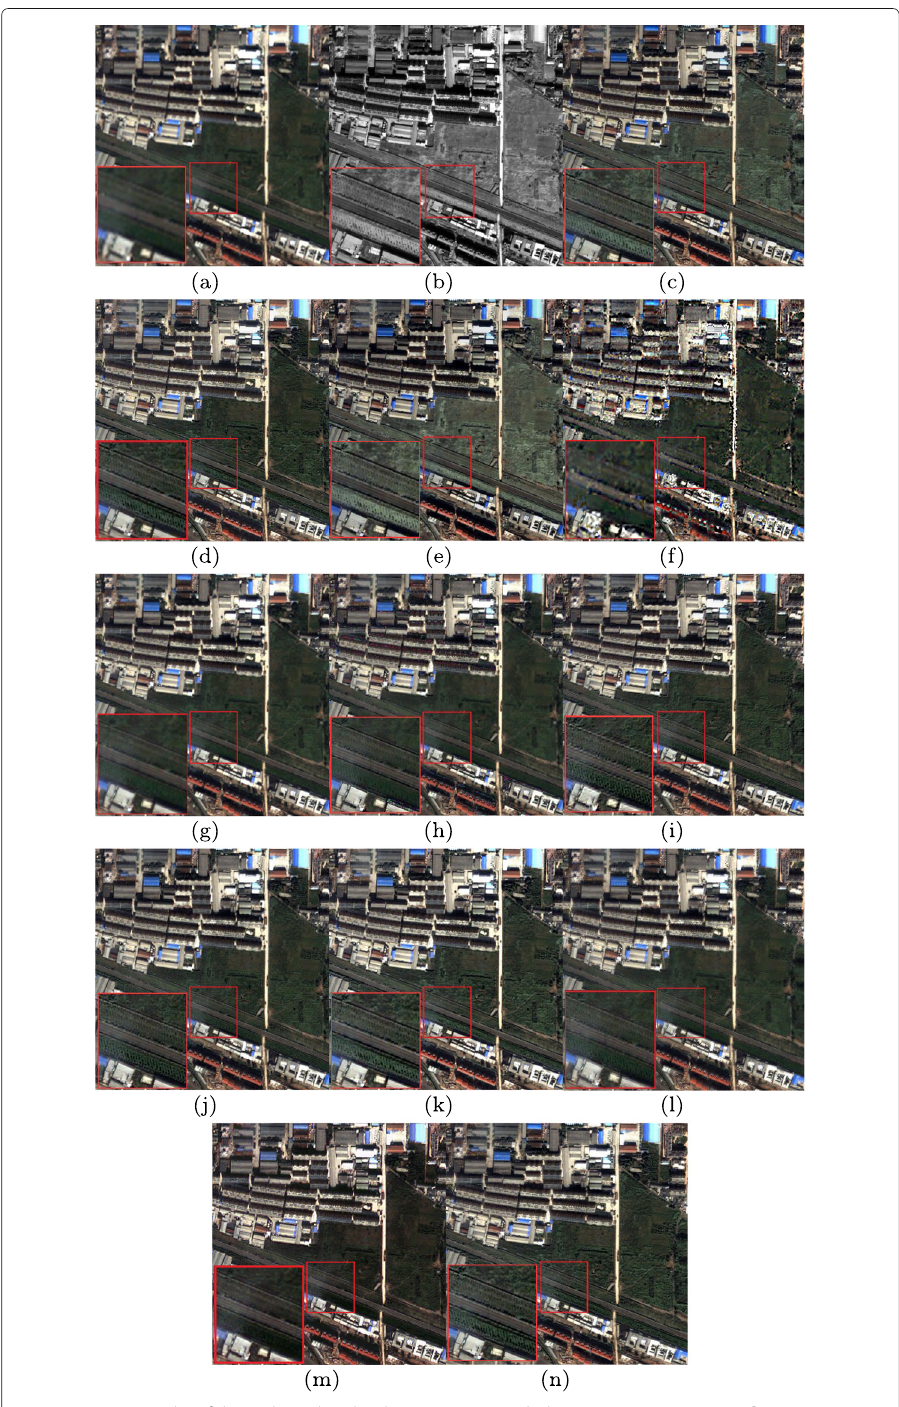
Fig. 10 Fusion results of the real QuickBird-2 dataset. a Upsampled MS image (1024 × 1024). b PAN image (1024 × 1024). c IHS method. d AIHS method. e PCA method. f BDSD method. g PRACS method. h